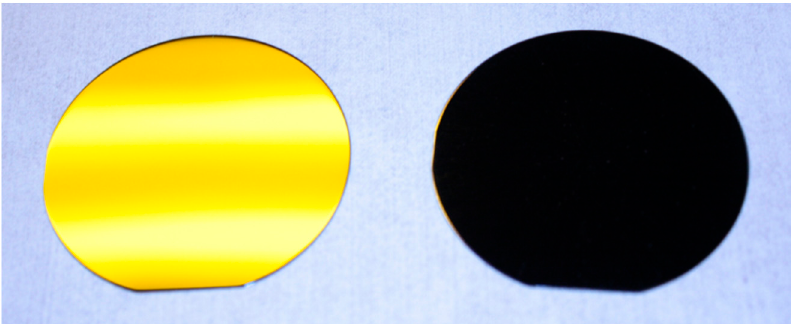
Figure 9. Surface images of 2-inch plain Si surface ( left ) and NT-structured Si surface ( right ).